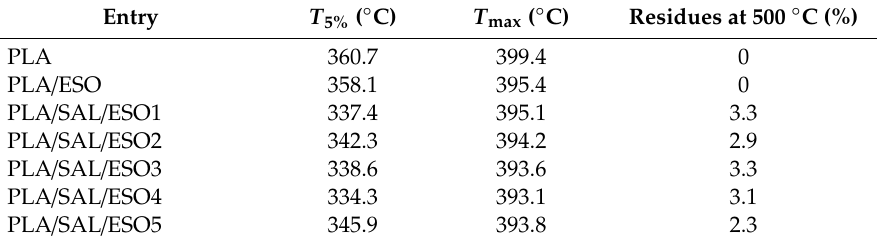
Figure 10. TGA and DTG curves of PLA, PLA/ESO, and PLA/SAL/ESO composites. Table 4. TGA weight loss of PLA, PLA/ESO, and PLA/SAL/ESO composites.